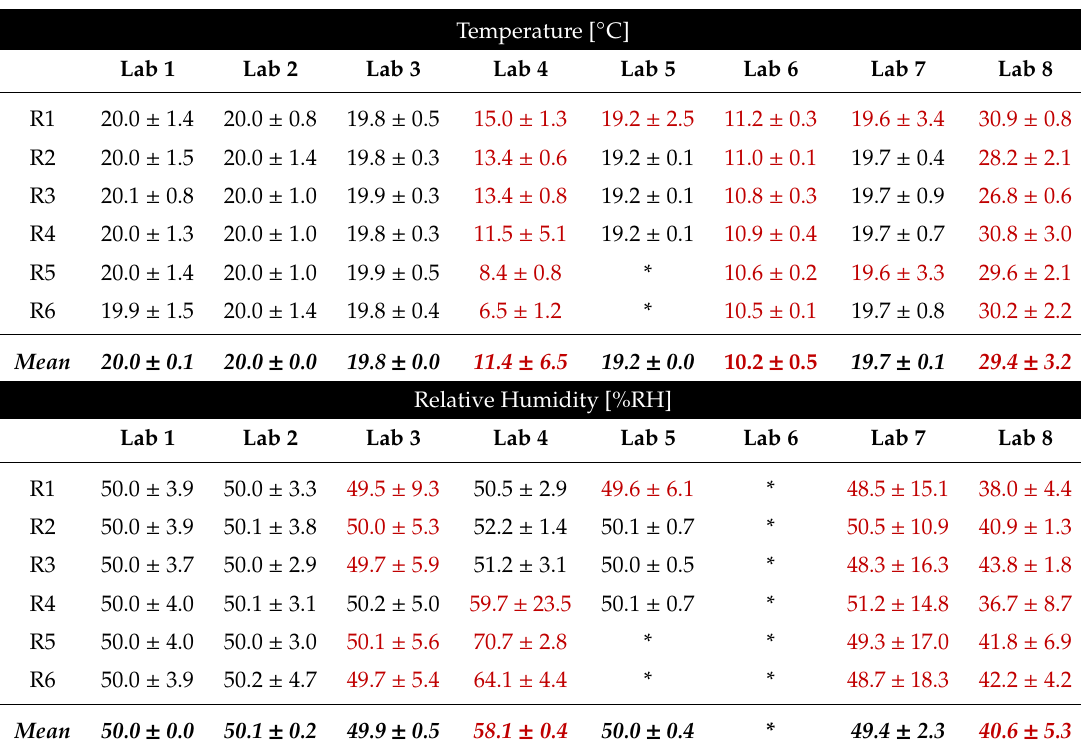
Table 6. Averaged temperature and RH of incoming air for T1—cells in red indicate non-compliant repeats and with an (*) data not available for that